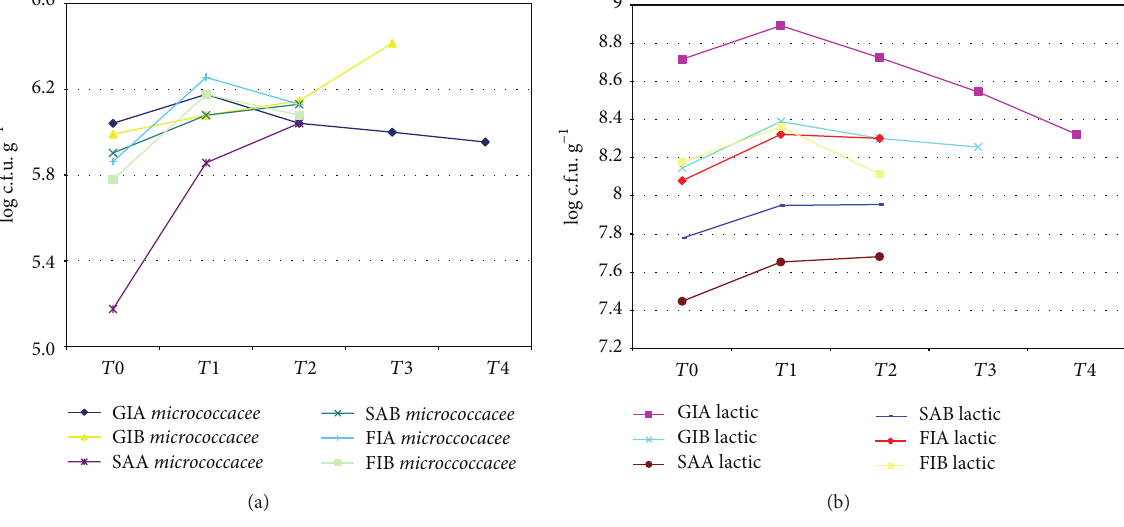
Figure 3(a) represents the score plot of the first two PCs; three main groups of samples can be identified: group 1: constituted by almost all samples belonging to Muletta